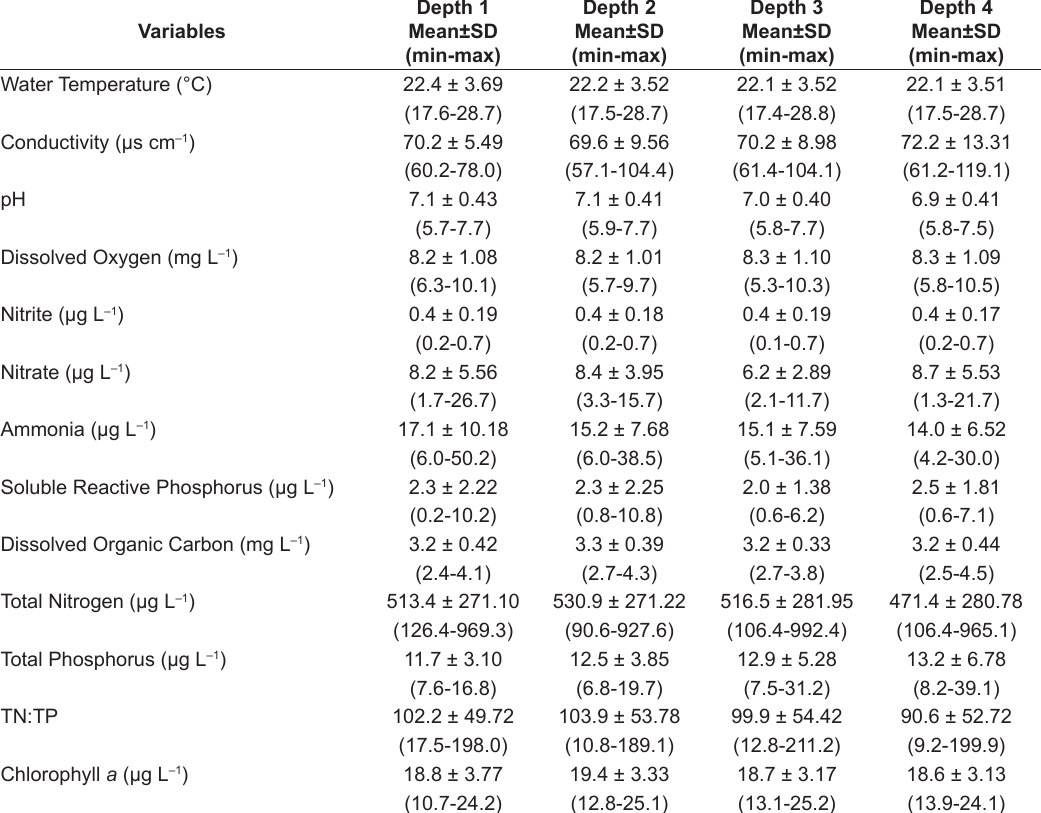
Table 1. Limnological variables sampled at four depths from June/09 to January/11 in the pelagic region of Peri Lake (mean, standard deviation, minimum and maximum).